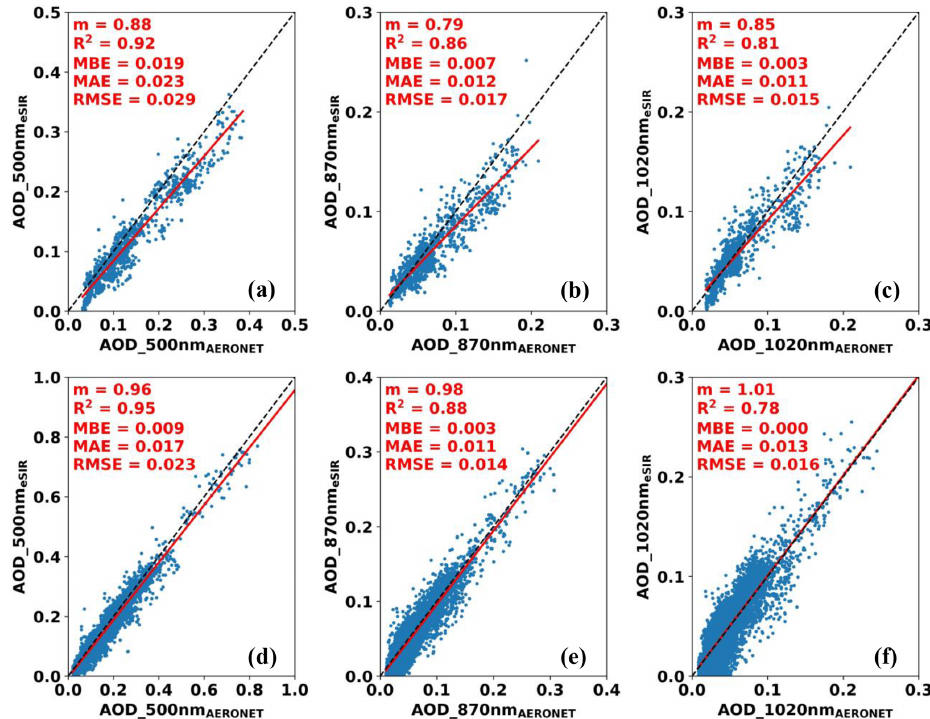
Figure 14. Scatterplots for the eSIR- and AERONET-derived AOD for three channels: 500, 870, and 1020nm at (a–c) Stony Brook and (d–f)